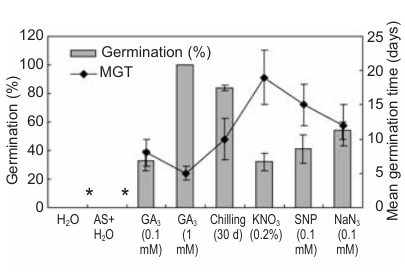
Figure 2. Effect of different seed pre-treat- ments on germination and mean germina- tion time of freshly harvested seeds of H. niger. Data are average of 3 replicates each ± s.d. AS: acid scarification; *no germina-